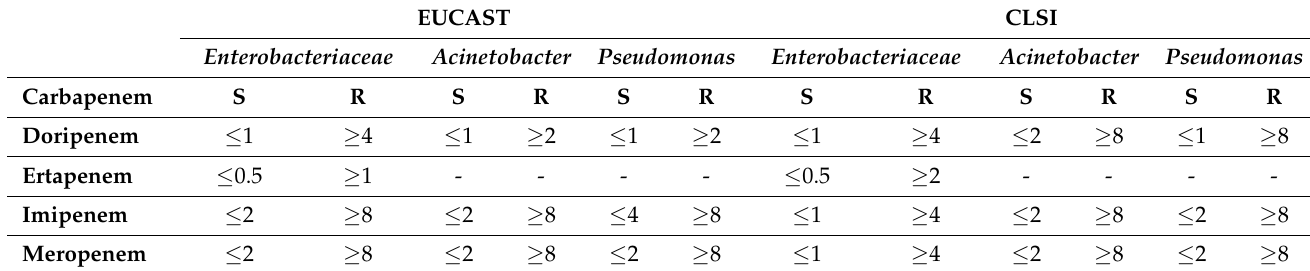
Table 1. Breakpoint values of minimum inhibitory concentration (mg/L) for carbapenems according to guidelines in Europe (EUCAST) and the United States